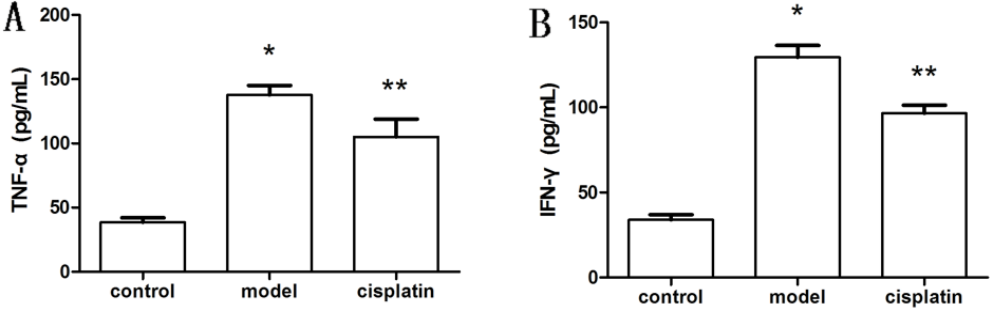
Figure 6. Effect of cisplatin on TNF- α and IFN- γ in ALF. ( A ) Serum levels of TNF- α ; ( B ) Serum levels of IFN- γ . Control: Control group, model: Model group, cisplatin: Cisplatin treatment group. Compared to the control group, * p < 0.05; compared to the model group, ** p < 0.05. Results are expressed as the mean ± SD ( n =